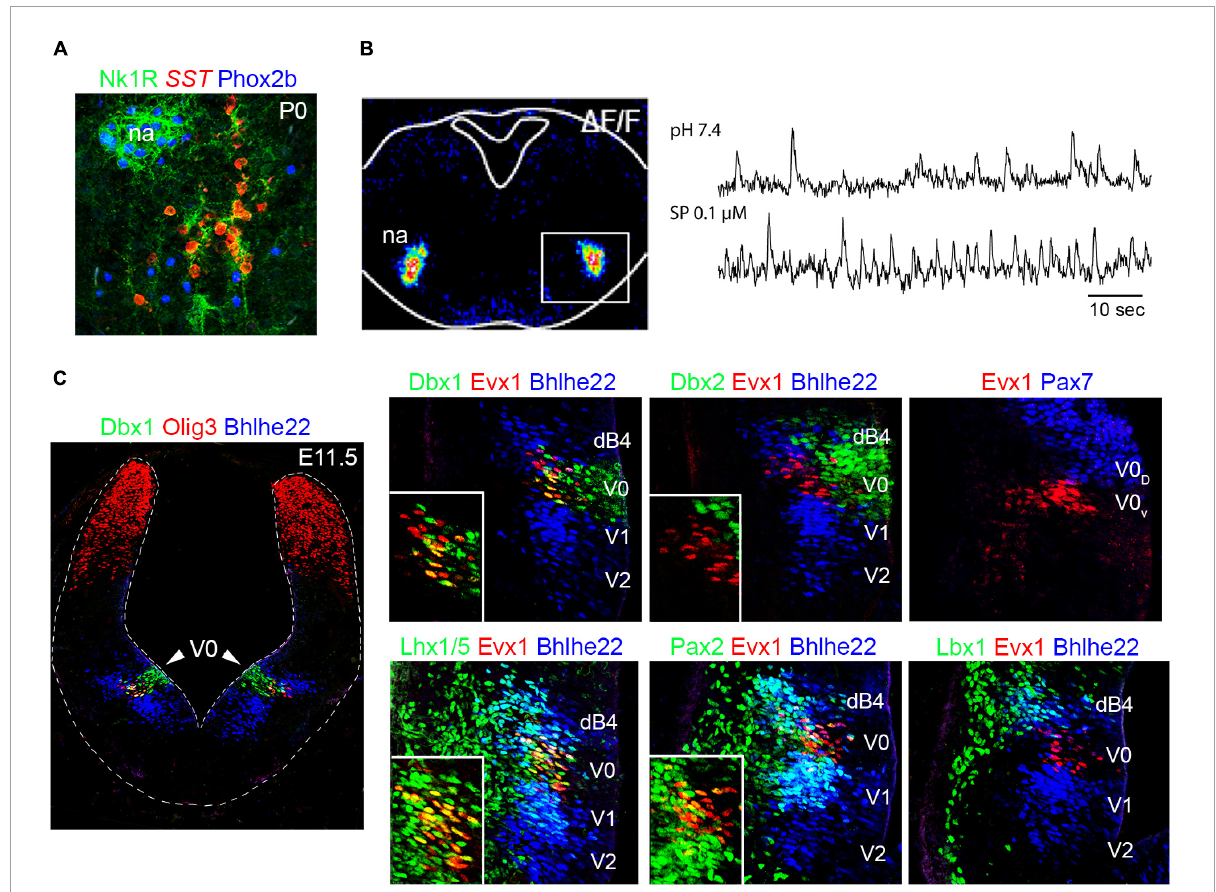
FIGURE7 Development of the preBötzinger complex. (A) The neurons of the preBötzinger complex locate ventral to the nucleus ambiguus (na) and can be distinguished by the co-expression of somatotatin (SST) and neurokinin 1 receptor (Nk1R) in mice at birth (P0). Please note that preBötzinger neurons co-express SST and Nk1R but not Phox2b, while motor neurons of the nucleus ambiguus co-express Nk1R and Phox2b but not SST. (B) Left, transverse section of a mouse hindbrain at E14.5 showing Ca2 + green-1AM fluorescence changes ( (cid:49) F/F) of preBötzinger complex (boxed area) intrinsic activity. Right, traces illustrating bursts of preBötzinger complex activity in physiological pH or after substance p (SP) treatment, which accelerates their firing. (C) Left, transverse section of a E11.5 mouse brainstem at rhombomere 7. The section was stained with antibodies against Dbx1 (green) Olig3 (red) and Bhlhe22 (blue). Note that the V0 progenitor domain can be distinguished by the expression of Dbx1. Right, histological characterization of the V0 progenitor domain and the neurons that emerge from it, using antibodies against Dbx1, Dbx2, Evx1, Pax7, Lhx1/5, Pax2 and Lbx1. Note the Dbx1 + (V0) progenitor domain generates Evx1 + neurons that co-express in addition Lhx1/5 and Pax2 but not Lbx1 (see also Tables 1 , 2 and text for more details). The expression of Bhlhe22 allows the distinction of the dB4 and